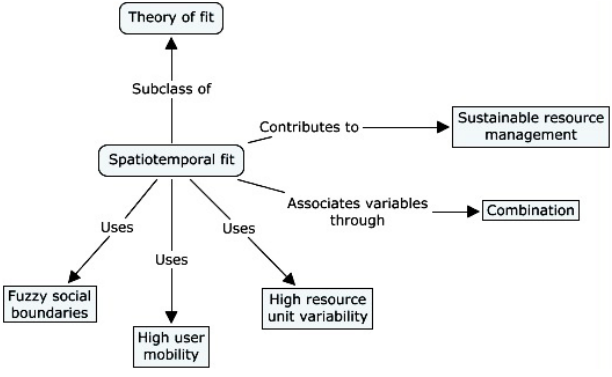
Fig. 5 . Spatiotemporal